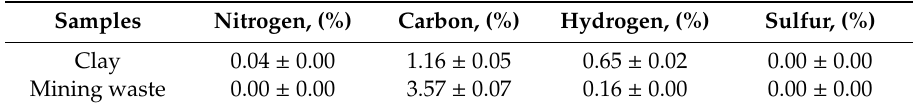
Table 2. Elemental analysis Carbon, Hydrogen, Nitrogen and Sulfur for clay and mining waste.